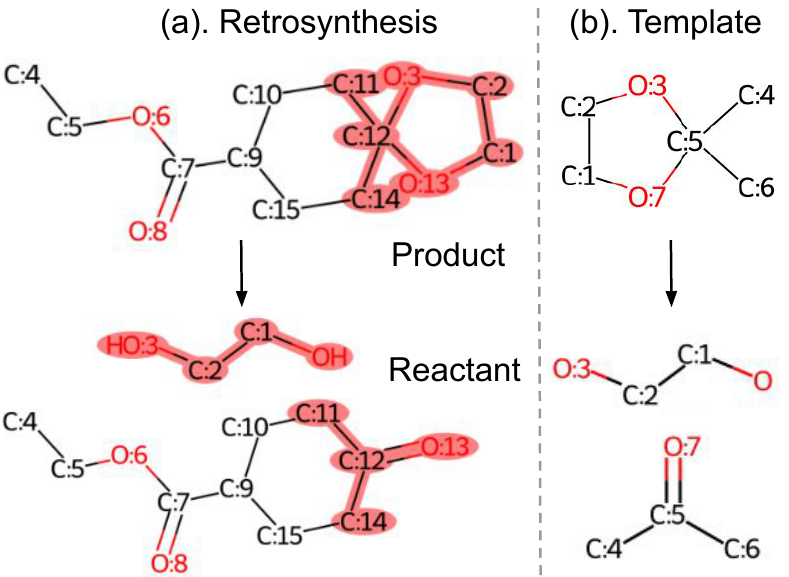
Figure 1. A retrosynthesis example from USPTO-50K dataset and its template extracted using an open- source toolkit. Note that the product and reactant are atom-mapped. The product and reactant subgraphs in ( b ) are highlighted in pink within the product and reactant molecule graphs in ( a ),